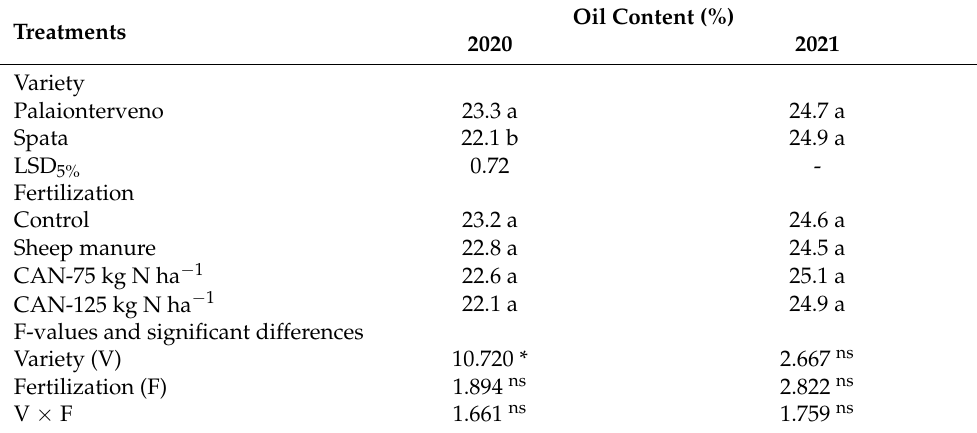
Table 6. Effects of two milk thistle varieties (Palaionterveno and Spata) and fertilization regimes (sheep manure and inorganic fertilization) on oil content in milk thistle.